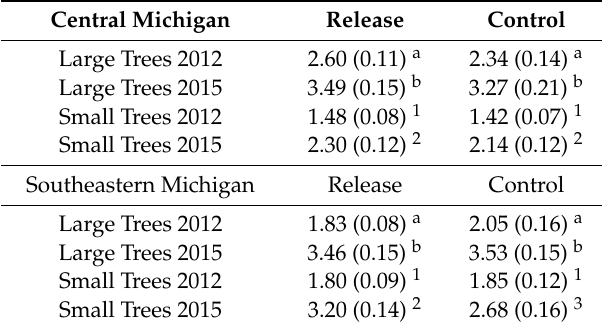
Table 2. Mean ( ± 1 SE) crown condition ratings for large and small trees in release and control plots in central and southeastern Michigan in 2012 and 2015. Crown condition ratings range from “1” for a healthy tree to “5” for a dead tree.